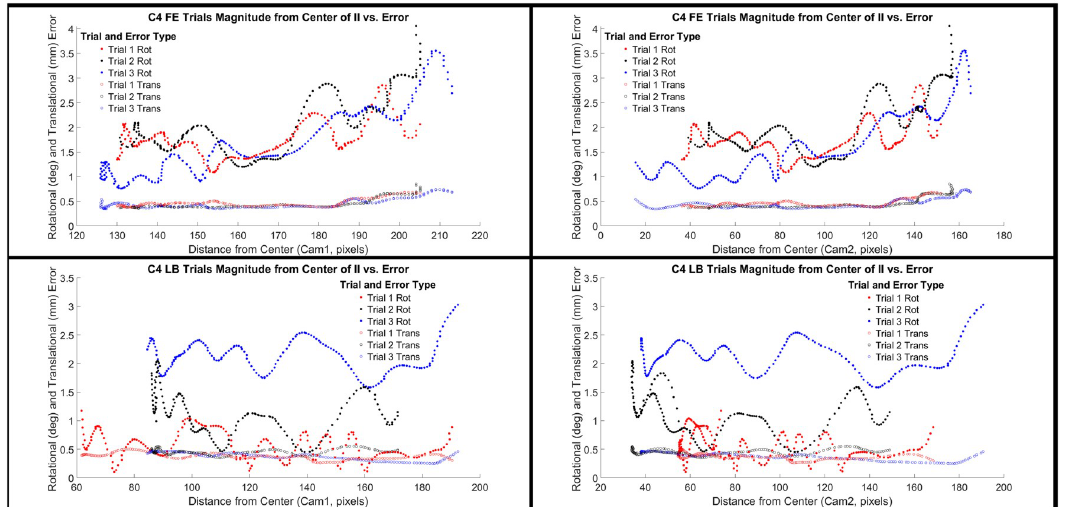
Fig 4. C4 distance from center of image intensifiers compared to tracking error. Overall rotational (degrees) and translational (mm) error magnitude is plotted against the distance of spinal level C4 relative to the center of the image intensifier (II) for each trial of flexion extension (FE) and lateral bending (LB) and each camera (1 and